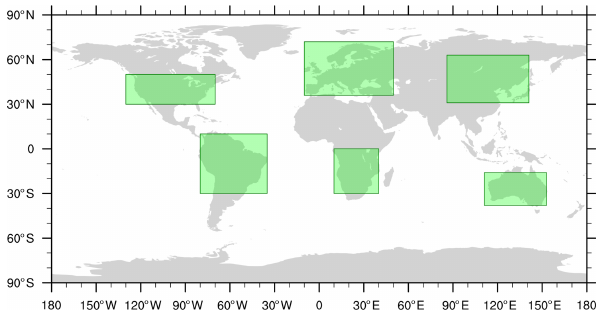
Figure 3. Borders of regions examined in this